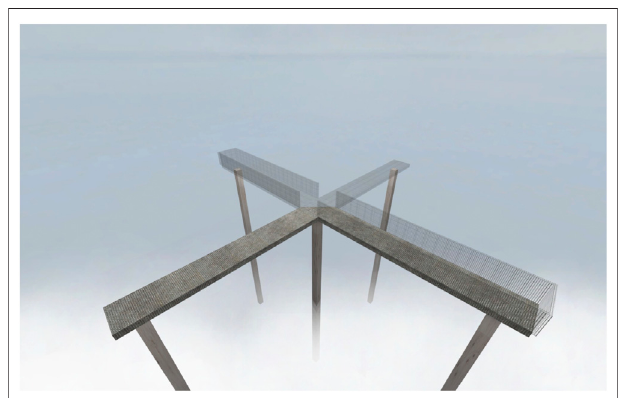
FIGURE 3 | Screenshot of the virtual EPM used in the second study. Walls on closed arms were lowered to handrail level and fl oor texture was modi fi ed to consist of see-through mesh and solid metal fl